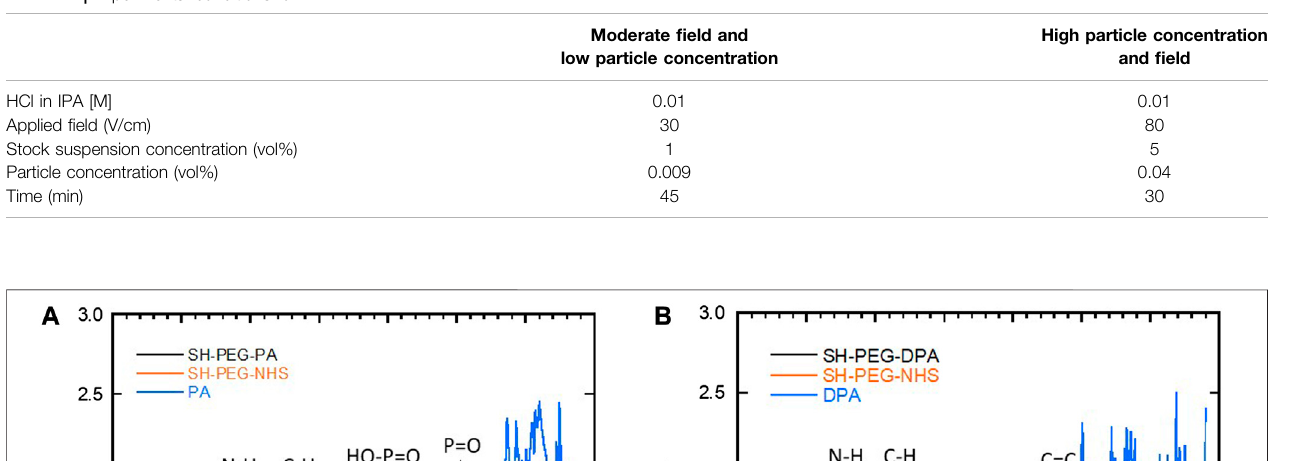
Frontiers in Chemistry |